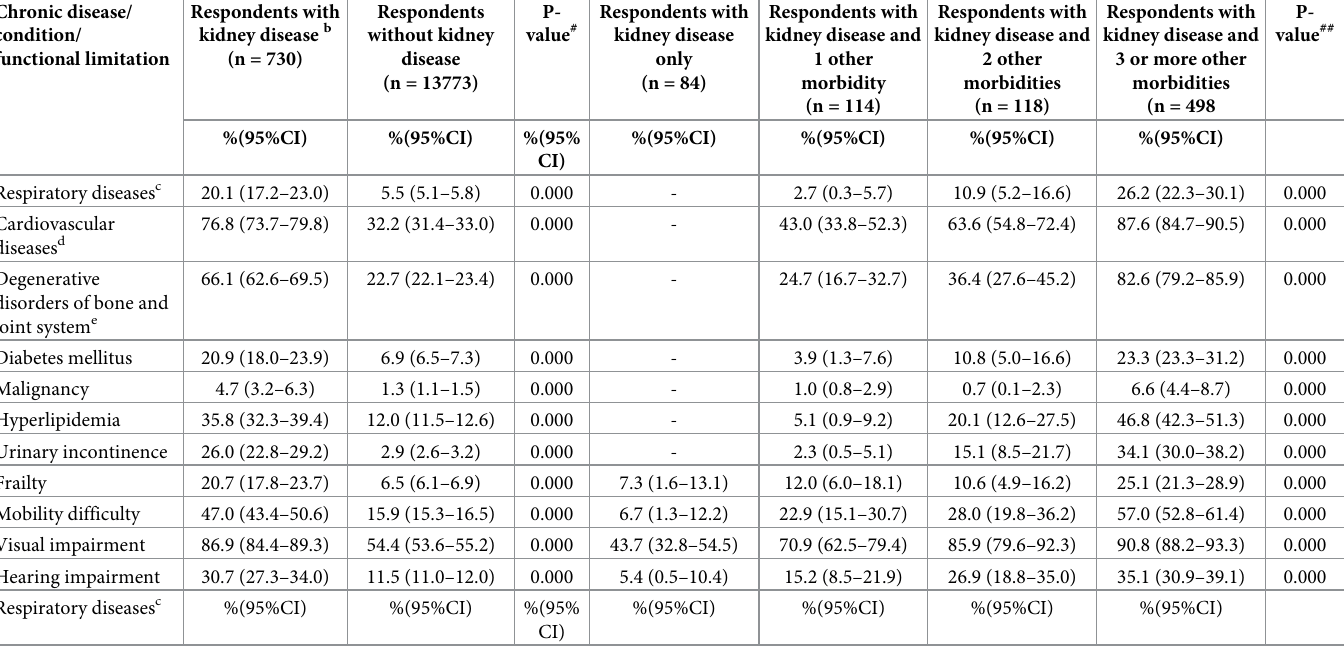
Table 2. Prevalence estimates for chronic diseases, conditions and functional limitations in respondents who reported presence of kidney disease, Republic of Ser- bia, 2013. Chronic disease/